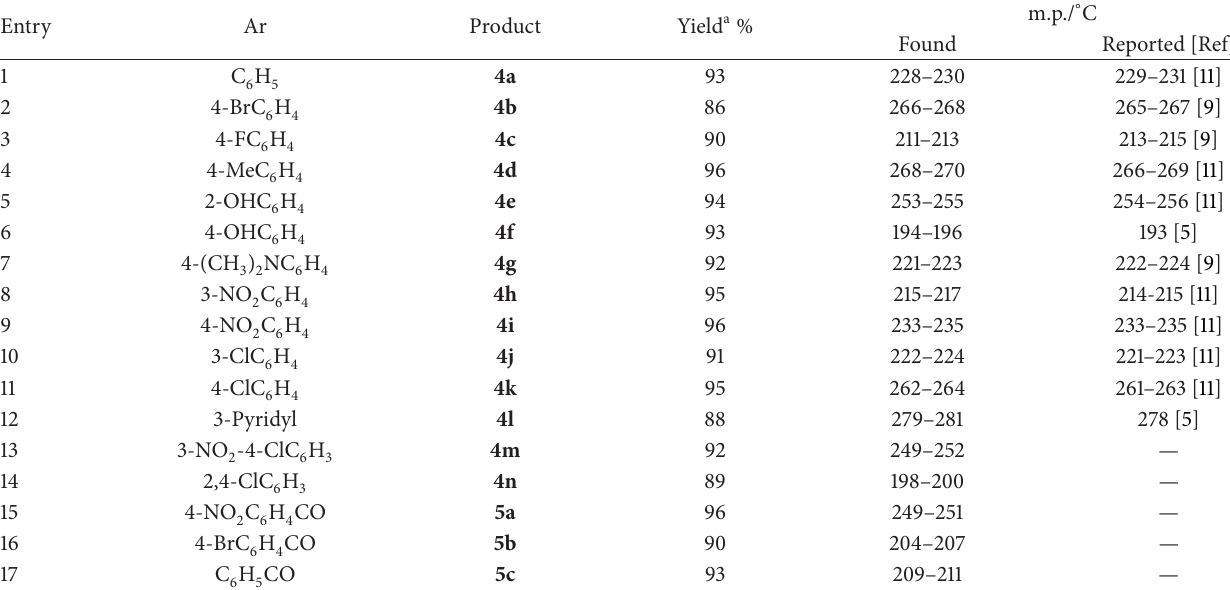
Table 2: SiO -OSO H NPs catalyzed the synthesis of biscoumarin 2 3